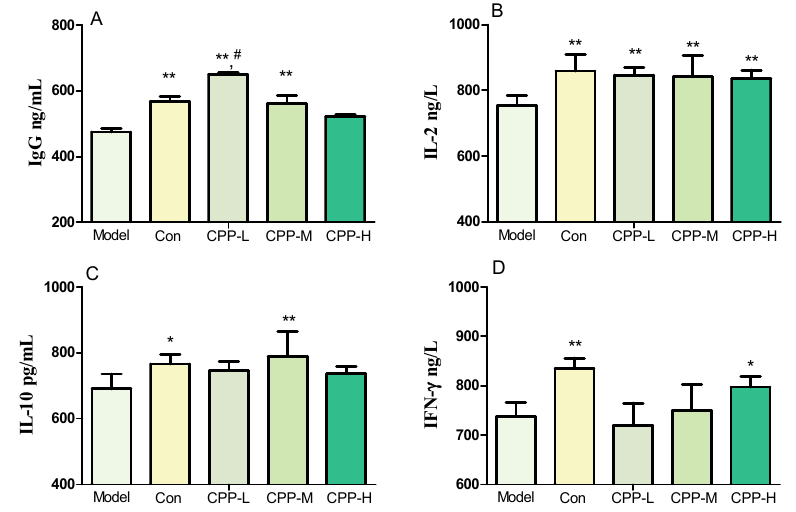
Figure 1. Effects of CPP on serum IgG ( A ), IL-2 ( B ), IL-10 ( C ), IFN- γ ( D ) concentration in cyclophosphamide-treated mice. Model, model control; Con, normal control; CPP-L, 50 mg/kg bodyweight CPP treated group; CPP-M, 100 mg/kg bodyweight CPP treated group; CPP-H, 200 mg/kg bodyweight CPP treated group. The values were presented as mean ± SD. * p < 0.05, compared with model group; ** p < 0.01, compared with model group; # p < 0.05, compared with normal group.